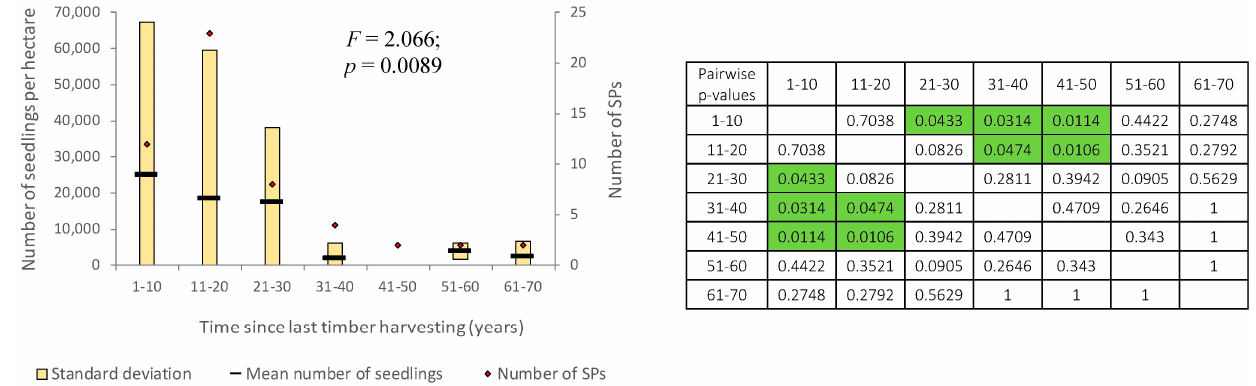
Figure 9. Tree species regeneration with respect to time period since last timber harvesting (green color highlights the significant differences: p < 0.05).